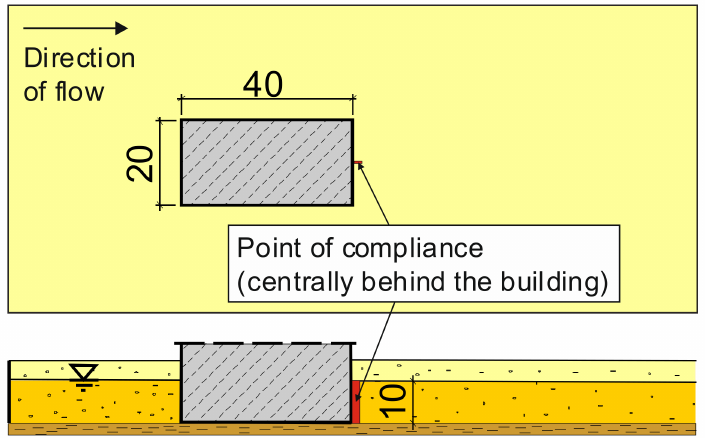
Figure 8. Top view and cross-section of the model scenario for concrete and concrete constituents (dimensions in m) adapted from [75], part